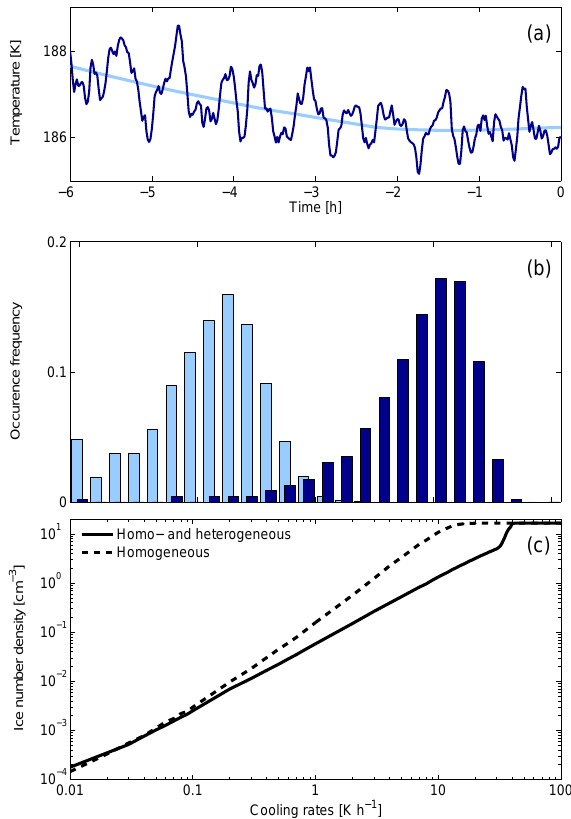
Fig. 2. (a) A typical synoptic-scale ERA-Interim trajectory (light blue), shown together with the same trajectory, with temperature fluctuations superimposed (dark blue). (b) The occurrence fre- quency of cooling rates on ERA-Interim synoptic-scale trajectories (light blue) and trajectories with superimposed temperature fluctua- tions (dark blue). (c) Simulated ice number densities versus cooling rates with only homogeneous ice nucleation (dashed curve) and in addition heterogeneous ice nucleation (solid curve).